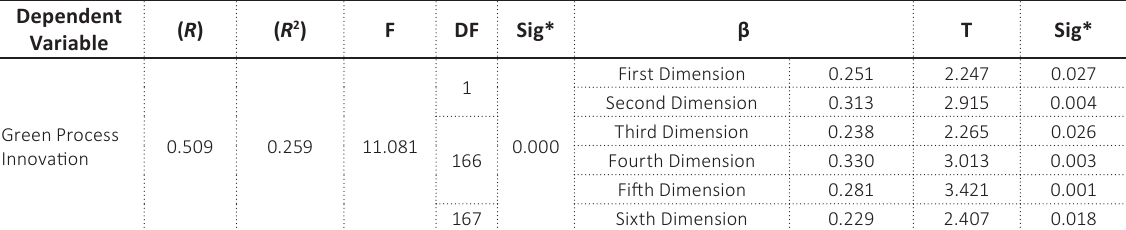
Table 3. Multiple regression analysis to guarantee the impact of GOI in green process innovation